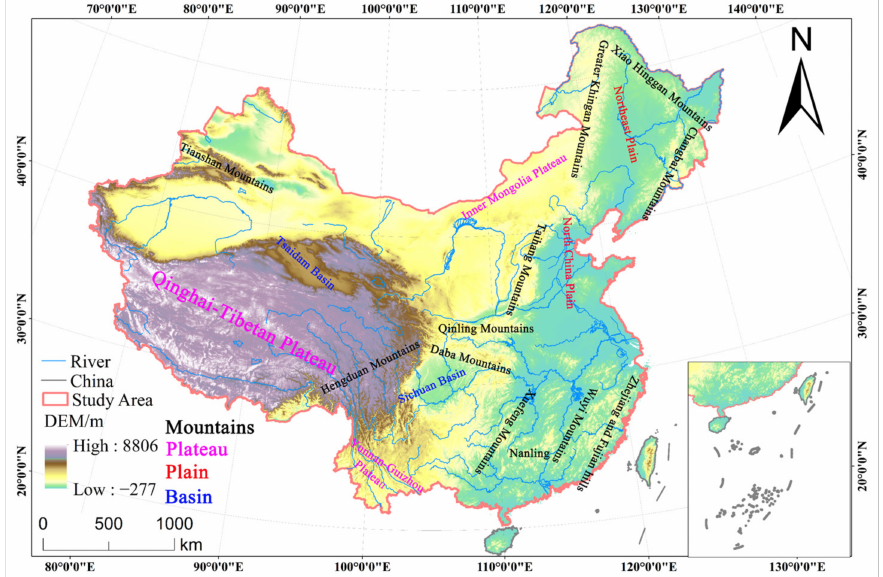
Figure 1. The geographic location of the study